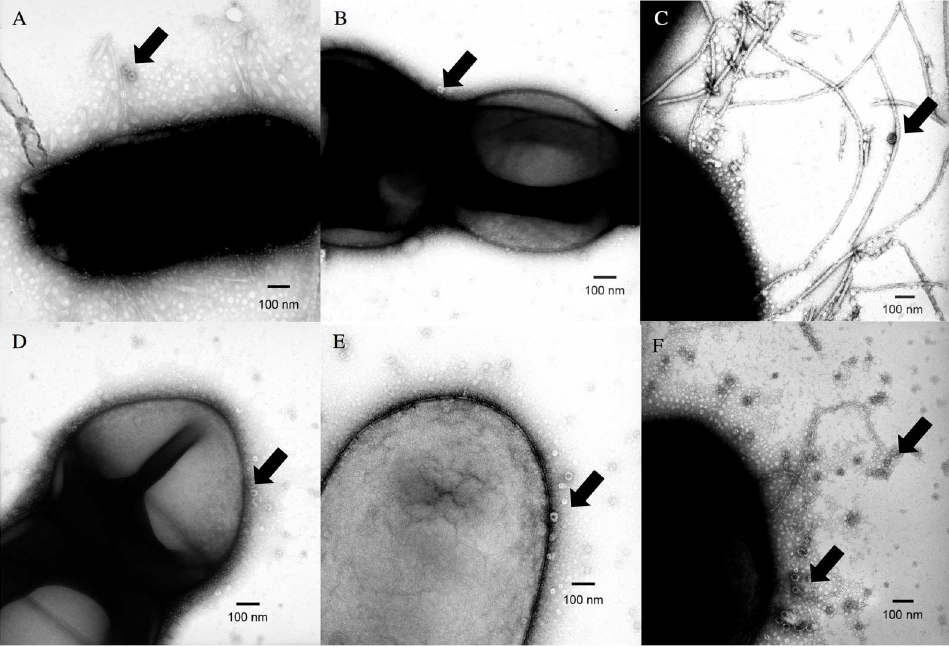
Fig 3. Transmission electronmicroscopy (50,000x)photos of selectbacteriato which GII.4 Sydney2012 (A-C) and GII.4 Farmington Hills 2002(D-F) VLPs are bound. Bacteria-VLP interactionsare shownas follows: (A) E . cloacae ,(B) S . aureus , (C) Bacillus spp., (D) E . faecium ,(E) Citrobacter spp., and(F) H . alvei .Representative VLPs arepointedout with thearrows, althoughadditionalVLPs arefrequentlyalsopresentin the image.Images shownare representative of multiplefieldsof